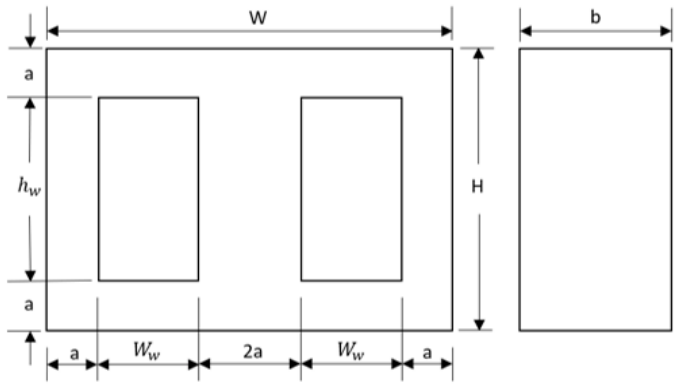
Figure 1. A scheme describing the dimensions of the single-phase shell-type transformer core. ‘ W ’ is the core width, ‘ H ’ is the core height, ‘ h w ’ is the window height, ‘ W w ’ is the window width, ‘ a ’ is the width of the outer limb and b is the core depth. The core parameters were optimized for the following power-grid transformer specifications: 125 kVA